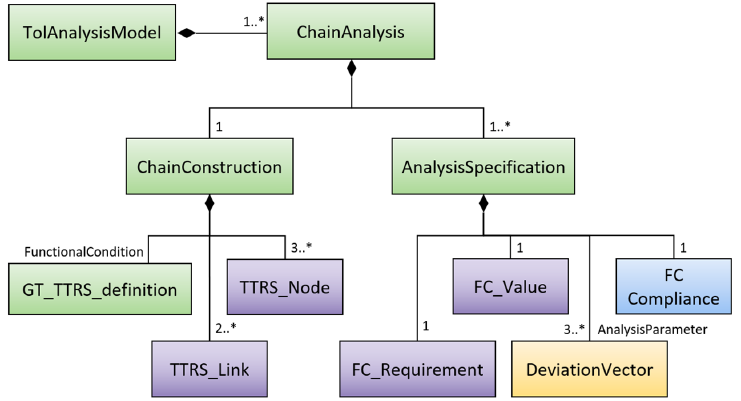
Figure 9. Abstract syntax of tolerance analysis model (“*” is a “zero to many” multiplicity). Table 1. FMLP sub-packages and